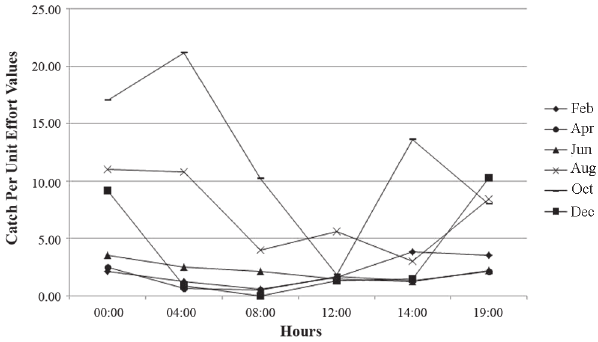
Fig. 4. Number of individuals (bars) and mean biomass of the population (line curve) of mexcalpiques during a hydrological cycle.